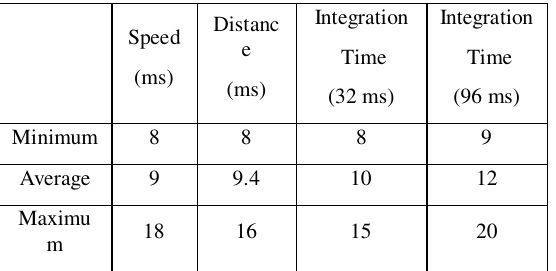
Table 4: Difference of time between image acquisition and segment